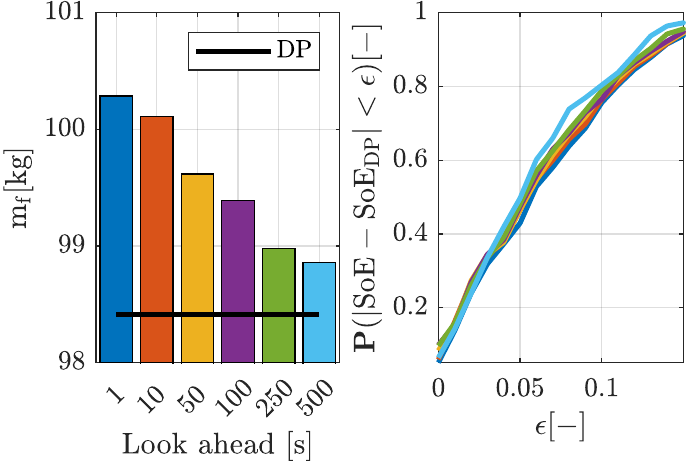
Figure 11. Impact of the look ahead on the fuel consumption obtained by the rollout strategy ( left ) and probability distribution of the deviation between the optimal SoE (DP) and that obtained by rollout with different look-ahead horizons ( right